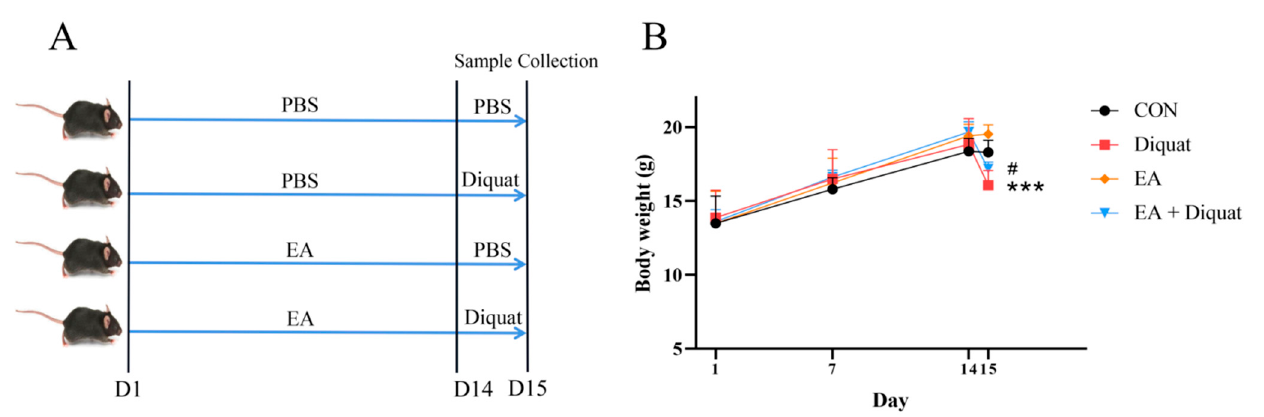
Figure 4. Ellagic acid alleviated diquat-induced jejunal oxidative stress through a Nrf2 mediated signaling pathway. ( A ) Immunohistochemistry analysis for Nrf2 in the jejunum tissue. ( B – D ) NQO-1, GPX1, and HO-1 mRNA expressions in jejunum tissue. All data were presented as mean ± S.E.M ( n = 4–6). *means p < 0.05 between two groups. CON, control; EA, ellagic acid; Nrf2, nuclear factor erythroid 2-related factor 2; NQO-1, NADPH dehydrogenase-1; GPX1, glutathione peroxidase 1; HO-1, heme oxygenase-1.